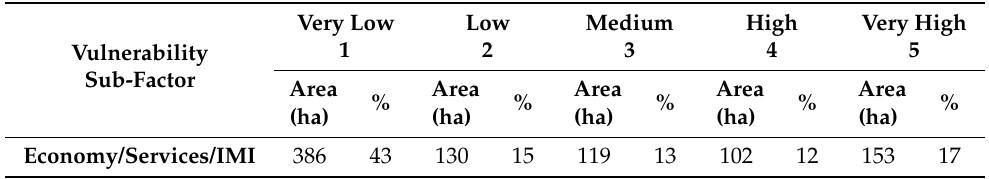
Table 28. Areas and percentages of the study area classified as each class of the economy/services/ IMI vulnerability